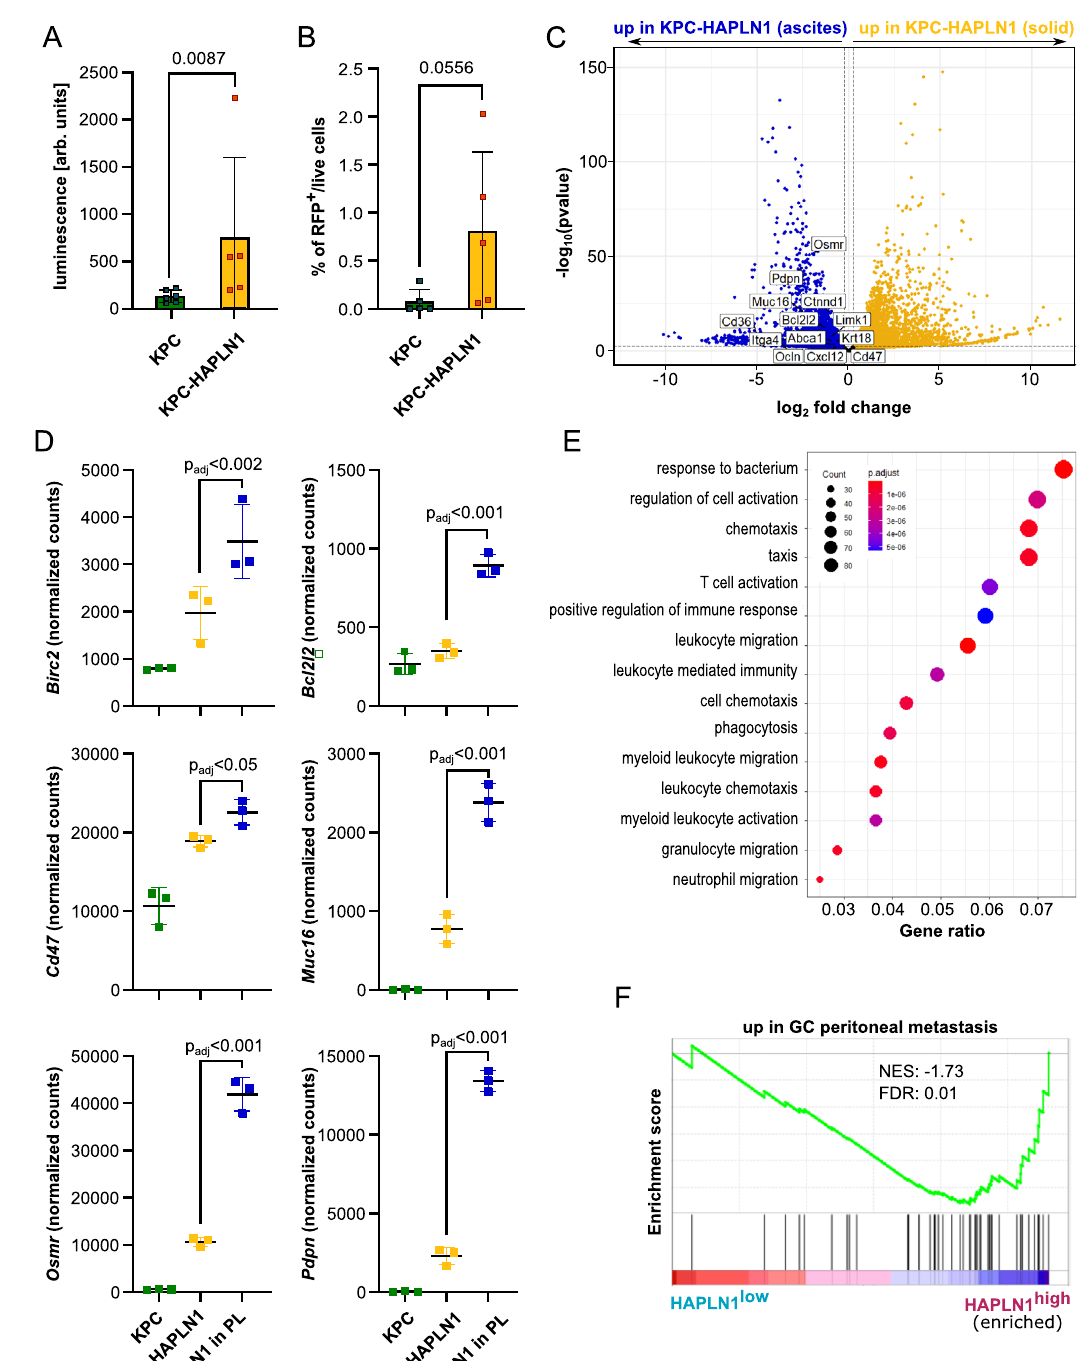
Fig. 7 | HAPLN1 facilitates peritoneal colonization by tumor cells. A Ex vivo luminescence measurement on peritoneal lavage of KPC and KPC-HAPLN1 mice 11 days after tumor injection. KPC n =6; KPC-HAPLN1 n =5. B RFP + tumor cells detected by fl ow cytometry in the peritoneal lavage of mice at day 11. n =5. C RNA sequencingresultscomparingKPC-HAPLN1cellsfromsolidtumororinsuspension in peritoneal lavage. Blue dots mark genes upregulated in cells in suspension, yellow dots genes upregulated in cells in tumor mass. Some genes of interest are highlighted. n =3. D Selected genes displayed using normalized read counts. n =3. E Gene Ontology of ‘ Biological Process ’ on genes upregulatedinKPC-HAPLN1 cells